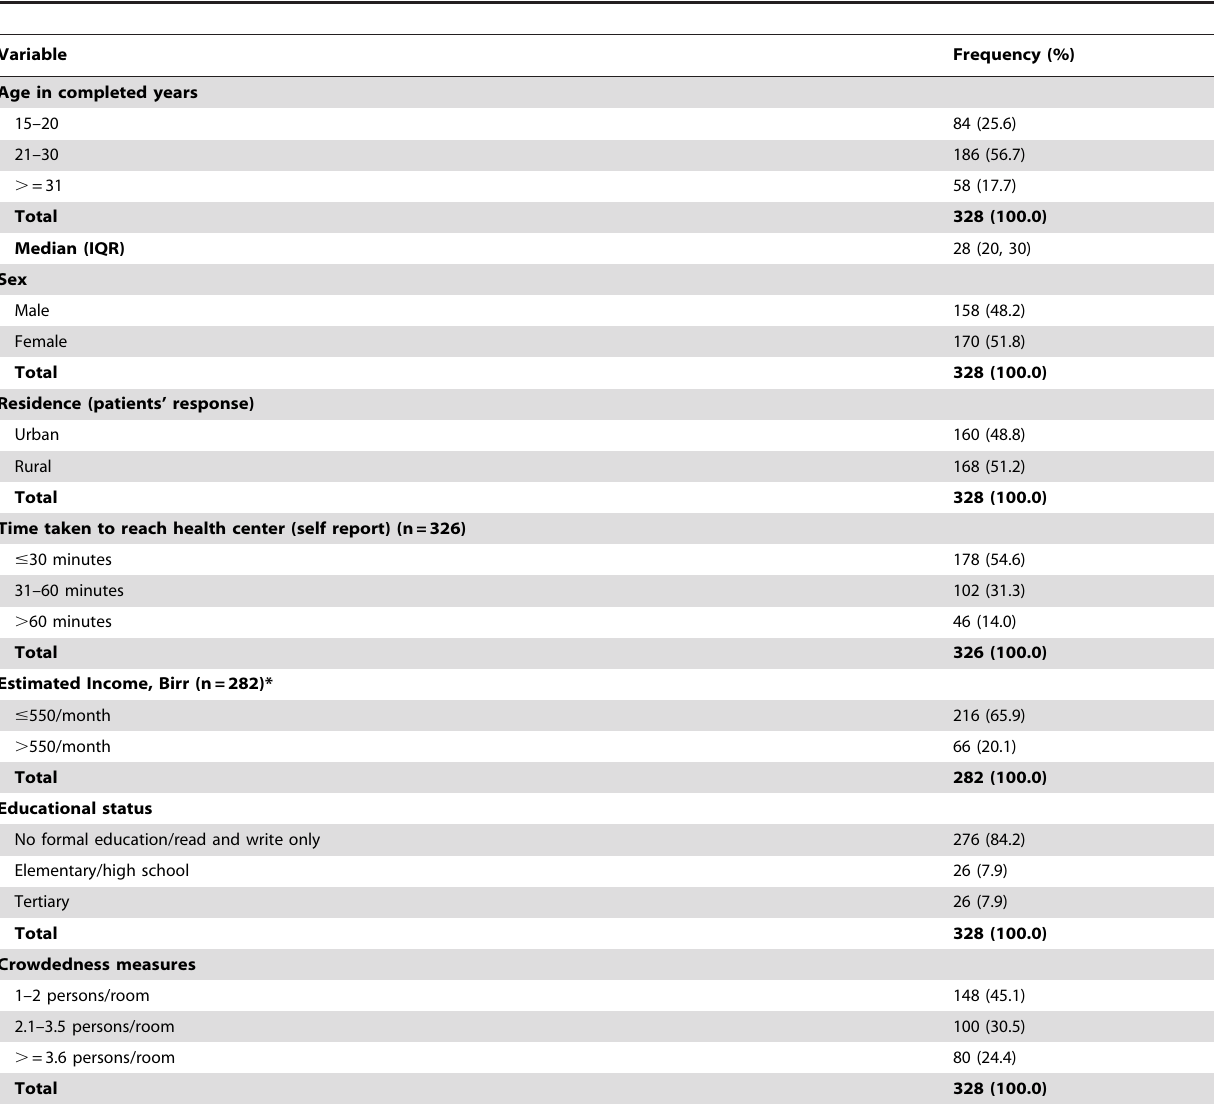
Table 1. Socio-demographic and other baseline characteristics of study participants, southern Ethiopia, June-December